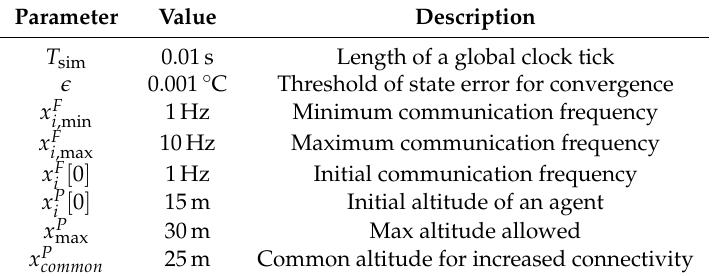
Table 1. Definitions and initialized value of